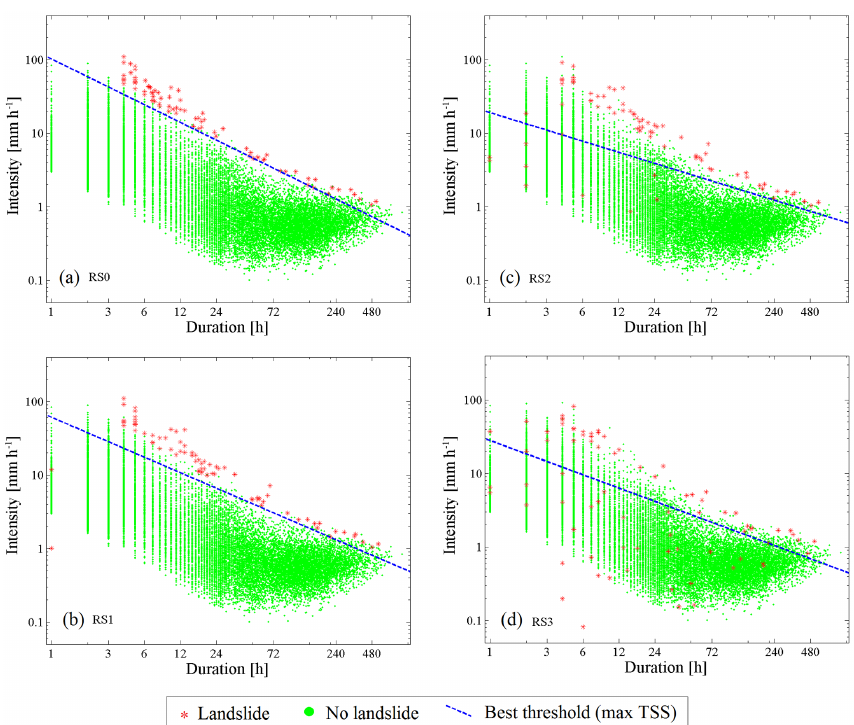
Figure 5. Scatter plot, in the double-logarithmic rainfall duration–intensity plane, of triggering and non-triggering events for hourly data and separation algorithm parameters u min = 24h, s min = 0 . 2mm. Thresholds correspond to the maximum performance in terms of true skill statistic. The plots show outcomes relative to (a) reference RS0, and (b–d) various erroneous reporting scenarios (RS1, RS2,